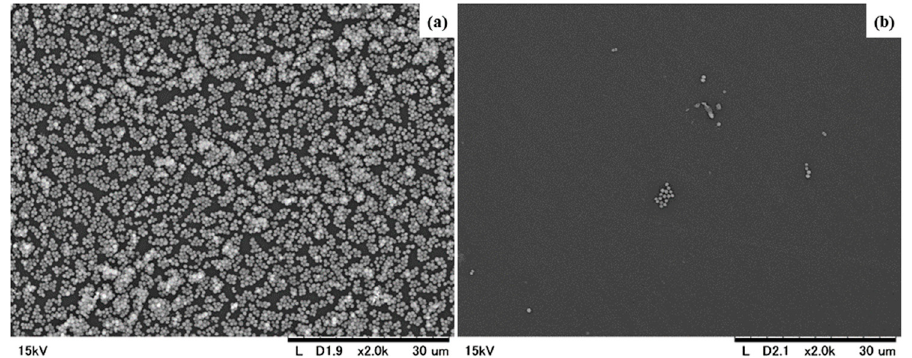
Figure 7. Scanning electron microscopy. Scanning electron microscopy micrographs of the untreated ( a ) and C18:1K-treated ( b ) biofilms that formed on the test pieces (2000×). MRSA biofilms formed on the test pieces after they had been incubated for 24 h at 37 °C. The MRSA biofilms that formed on the test pieces were removed by C18:1K. ( a ) An untreated biofilm that formed on a test piece; ( b ) A biofilm that had been treated with C18:1K for 1 min.